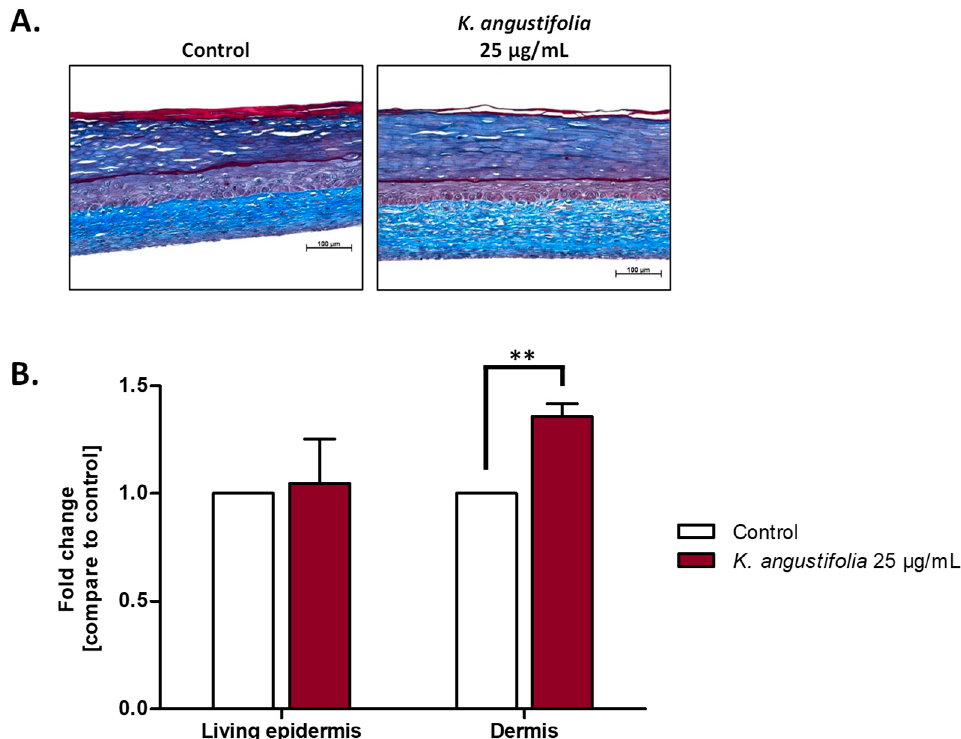
Figure 4. Effect of the K. angustifolia extract on reconstructed skin substitutes histology. ( A ) Histological analyses of Masson’s trichrome stained skin substitute sections. Stratum corneum in dark blue, living epidermis in violet and dermis in light blue. Objective 10 × , scale bar: 100 µ m. ( B ) Fold change in the thickness of the living epidermis and dermis. Fold change is defined as the ratio of treated substitutes’ thickness value to the control (without treatment) thickness value. Two substitutes for each condition were analyzed and confirmed with three different cell populations ( N = 3, n = 6). Data are presented as means of the three different cell populations ± S.D. Statistical significance was determined using a t -test, ** p -value < 0.01.